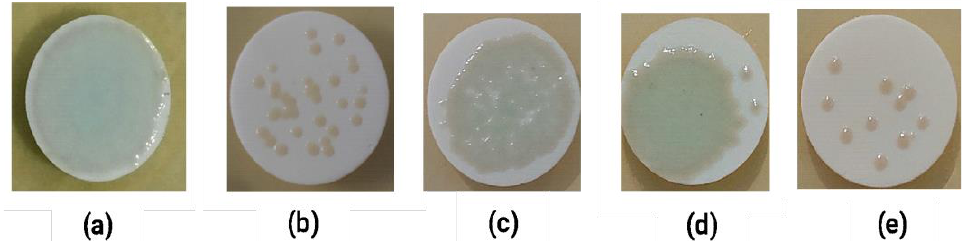
Figure 9. Macroscopic appearance of Pseudomonas aeruginosa biofilm treated with L-tartaric acid (TLA), glucaric acid (GA), D-sorbitol (DS), and ascorbic acid (AA). ( a ) Blank (control), ( b ) TLA, ( c ) GA, ( d ) DS, and ( e ) AA.